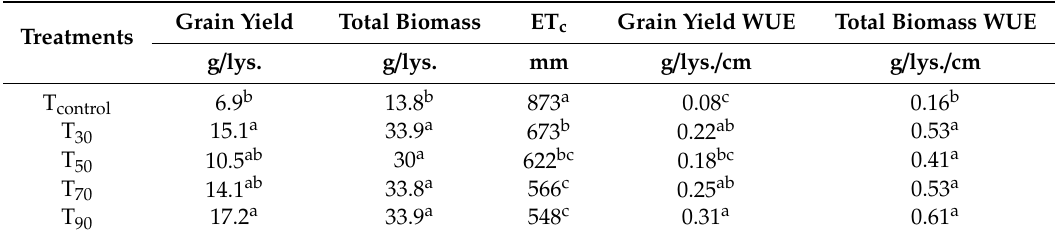
Table 4. Average of grain yield, total biomass, measured evapotranspiration (ET c ), grain yield and biomass WUE for di ff erent treatments in controlled greenhouse